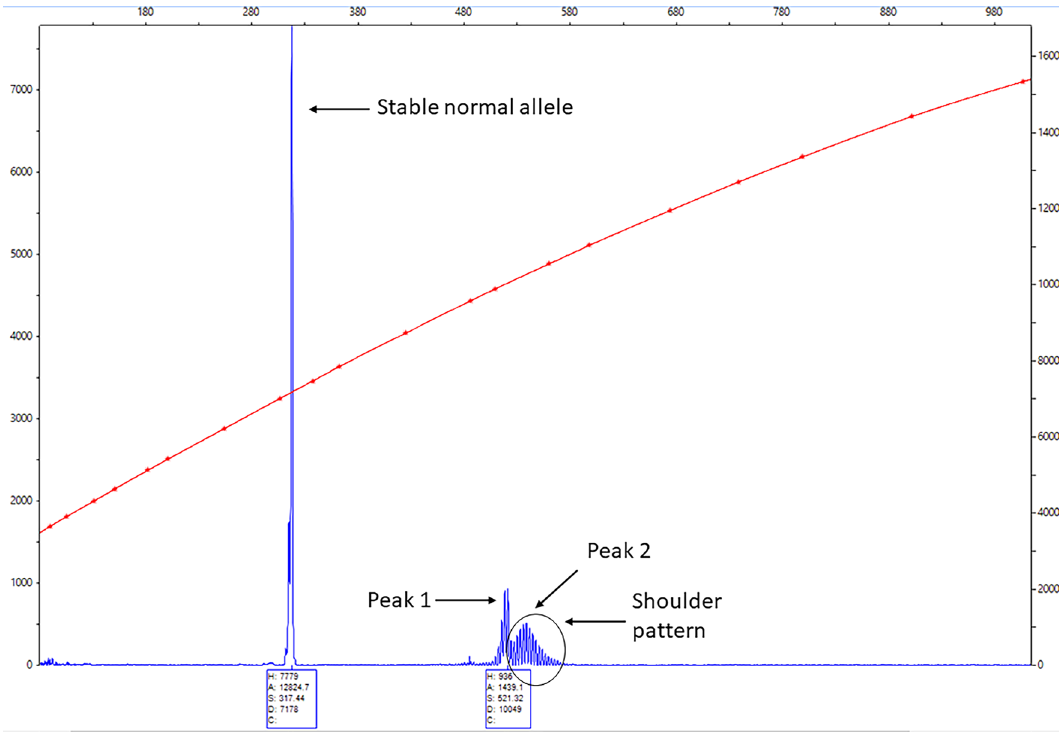
Figure 1. Example of a PCR profile (visualized by a Capillary Electrophoretogram) observed in a female PM showing somatic allelic instability. The degree of CGG instability is shown as a shoulder pattern (serial of peaks) located to the right side of the premutation allele peak. Instability is calculated as Peak 2 (unstable premutation allele size, highest peak size of the shoulder pattern) minus Peak 1 (stable premutation allele size on the left of the shoulder pattern) as described in Hwang et al.